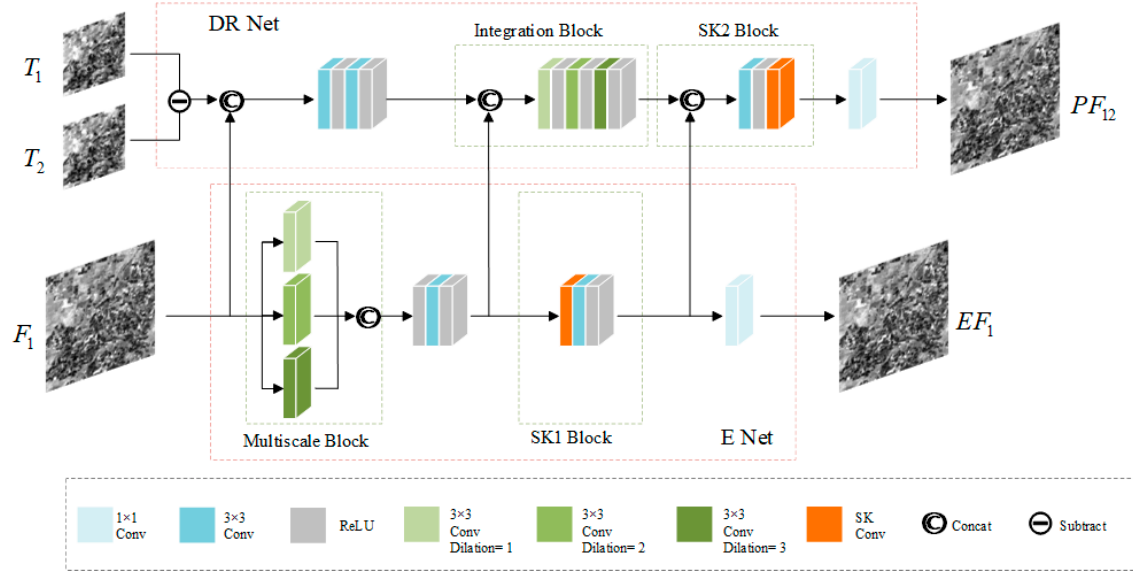
Figure 3. DR Net and E Net Architecture of the training process at time t 1 . The E Net uses the Multiscale Block and SK1 Block to extract the high-frequency information of fine image F 1 and then concatenate it into DR Net to assist DR Net to achieve more accurate fine-difference image reconstruction. DR Net is mainly composed of the Integration Block and SK2